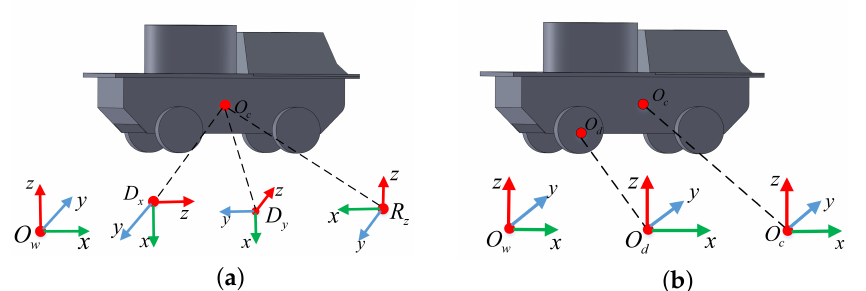
Figure 3. The kinematic modeling of the mobile platform. ( a ) Kinematic modeling based on the DH method; ( b ) Kinematic modeling based on the optimized